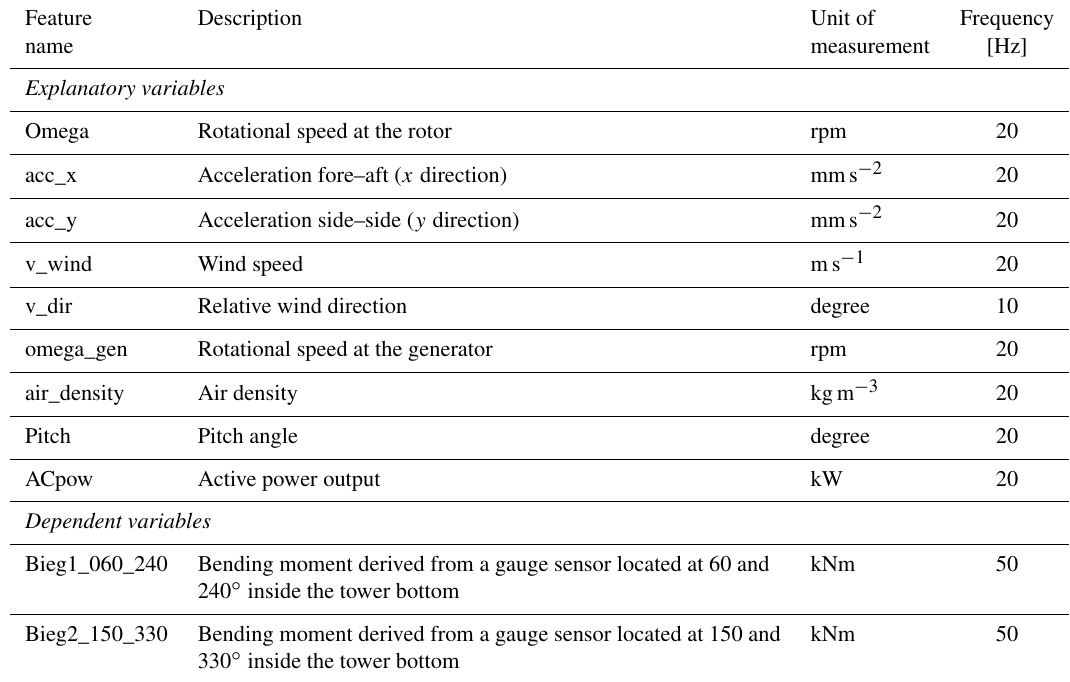
Table 1. Description of SCADA sensors